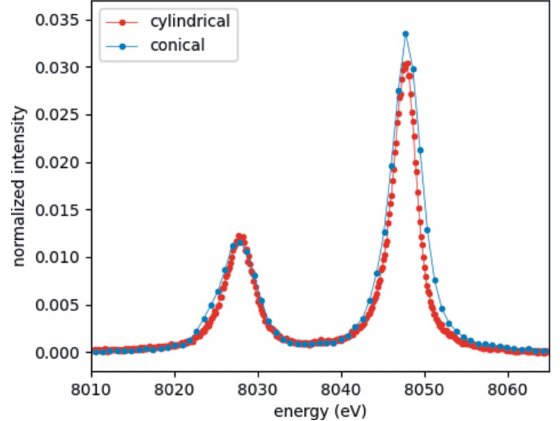
Figure 9 Cu K (cid:2) 1 peaks recorded by the conical-based von Ha´mos spectrometer with a Cu anode polycapillary source at different detector positions (see text and caption of Fig.